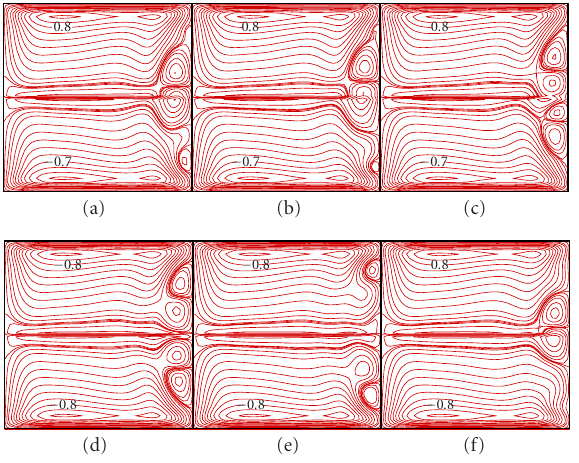
Figure 9: Typical secondary-flow patterns of chaotic oscillation for the case in Figure 8c ( σ = 0 . 02, Pr = 0 . 7, Dk = 300, L 1 = 28, and L 2 = − 11 . 7); (a) τ = 0 . 786, (b) τ = 0 . 795, (c) τ = 0 . 806, (d) τ = 0 . 815, (e) τ = 0 . 824, and (f) τ = 0 . 833.